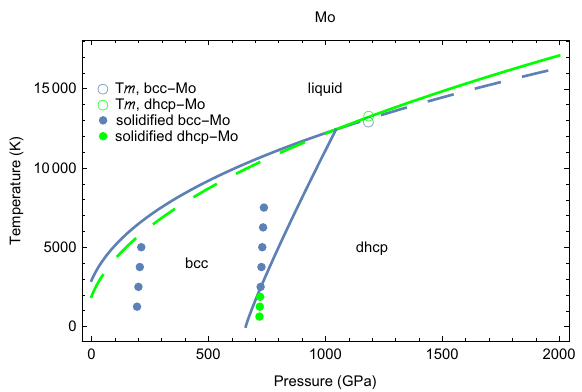
Figure 5. Ab initio phase diagram of